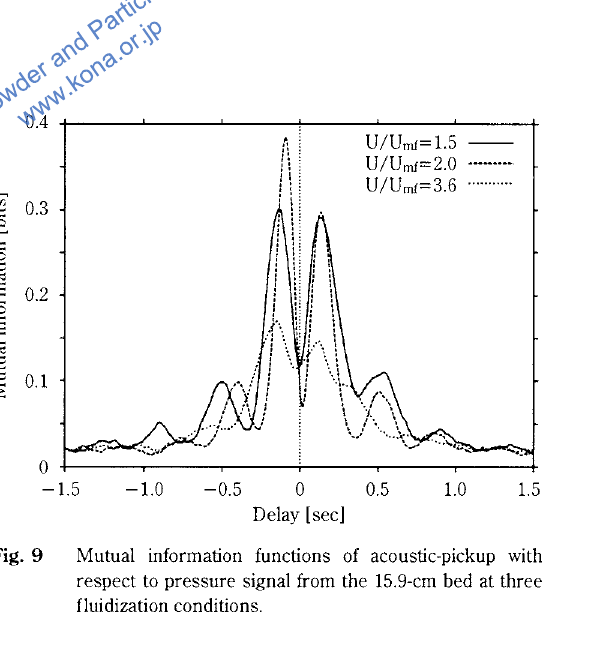
Mutual information functions of acoustic-pickup with respect to pressure signal from the 15.9-cm bed at three fluidization